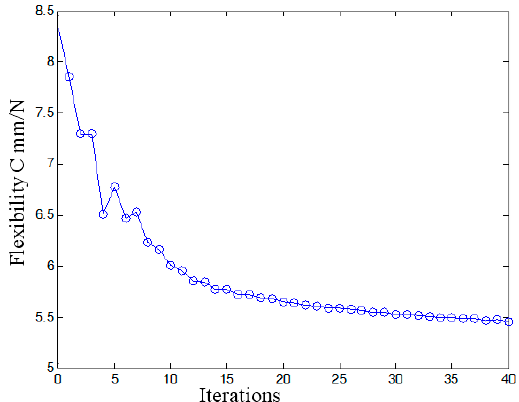
Figure 17. The flexibility iterative times during the multi-objective topology optimization.